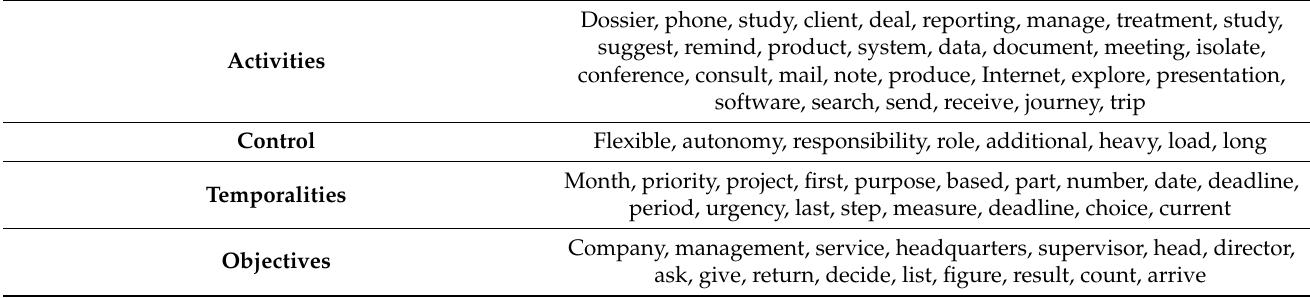
Table 3. Themes associated with the specific vocabulary of Class